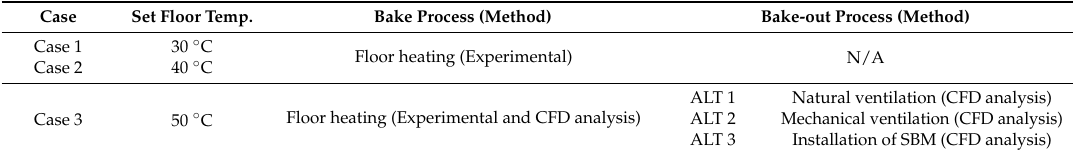
Table 1. Floor temperature and bake-out conditions per case for bake-out experiment. Case Set Floor